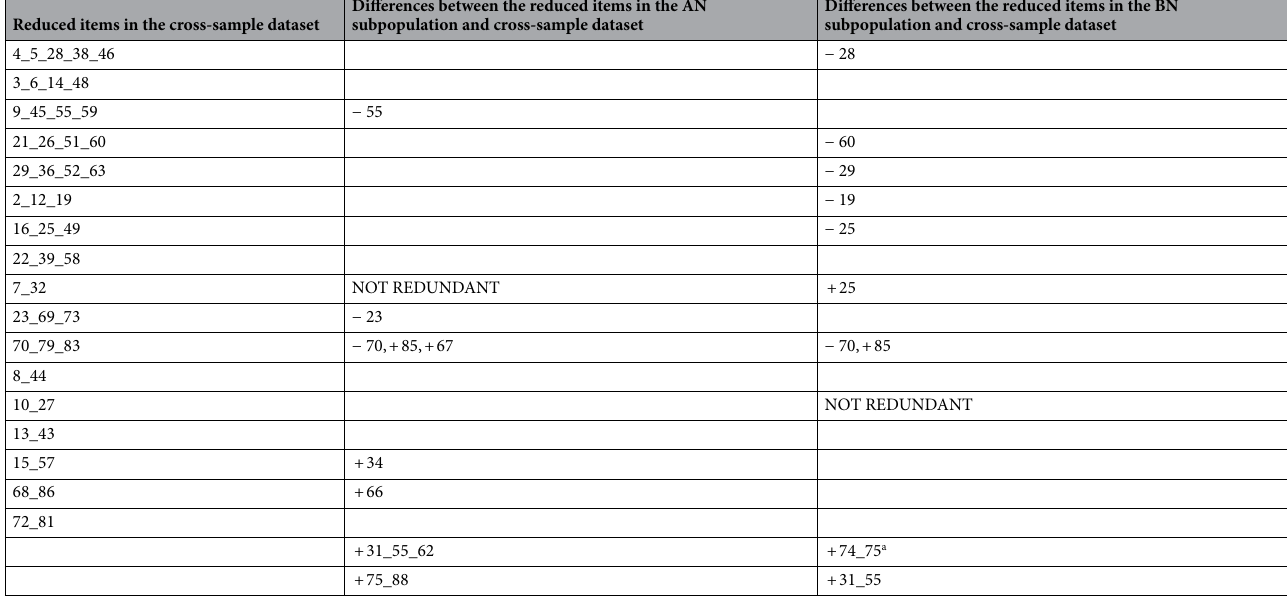
Table 3. Comparison of redundant EDI-3 items between the AN and BN subpopulations and the cross- sample dataset, as detected via UVA. The plus sign (+) in front of item numbers in the second and third columns indicates that such items have been combined with those specified in the first column. Similarly, the minus sign (−) indicates that such items are missing, that is, they are not redundant in the diagnosis-specific datasets. a The redundant pair 74 and 75 detected in the BN subsample is particularly interesting as it is the only one involving items of two different subscales, namely IA and A in this specific